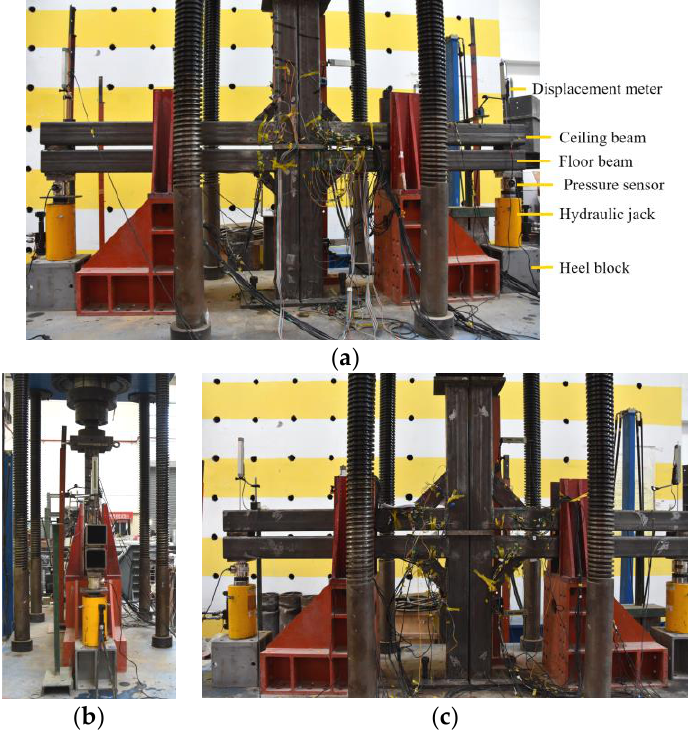
Figure 11. Testing site. ( a ) Front view of S1 ( b ) side view of S1 ( c ) front view of S2.